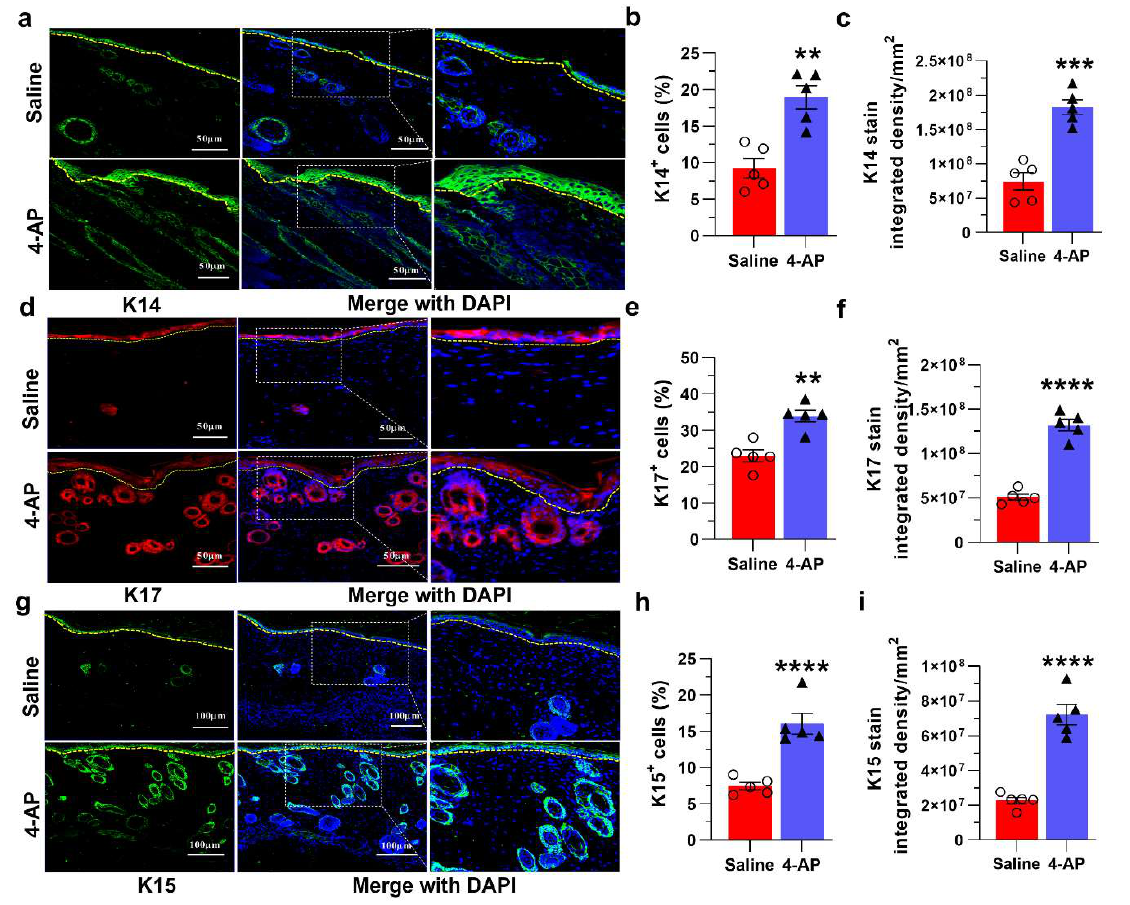
Figure 2. 4-AP increases keratinocyte number and epithelial stem-cell markers in healing wounds. ( a ) Representative images of Keratin 14 protein expression by immunofluorescence in healed epi- dermis. K14 (green); DAPI (blue) denotes nucleus and dashed line denotes epidermal/dermal border. ( b , c ) Percent of K14 + cells and K14 protein integrated density in saline-control and 4-AP-treated skin wounds at day 14. Scale bars = 50 μm. Data represents 20 images from 5 different mouse wounds and are shown as mean ± SEM, n = 5 animals per group, statistical significance indicated by asterisks (O = saline mouse data points, ∆ = 4-AP treated mouse data points, ** = p between 0.01 and 0.001, and *** = p between 0.001 and 0.0002 vs. saline). ( d ) Representative images of keratin 17 protein expression by immunofluorescence in saline and 4-AP-treated skin wounds. K17 (red); DAPI (blue) denotes nucleus and dashed line denotes epidermal/dermal border. ( e , f ) Percent of K17 + cells and K17 protein integrated density in control and 4-AP treated skin wounds at day 14; scale bars = 50 μm. Data represents 20 images from 5 different mouse wounds and are shown as mean ± SEM, n = 5 animals per group, statistical significance indicated by asterisks (O = saline mouse data points, ∆ = 4-AP treated mouse data points, ** = p between 0.01 and 0.001, and **** = p between 0.0002 and 0.0001 vs. saline). ( g ) Representative images of keratin 17 protein expression by immunofluorescence in saline and 4-AP-treated skin wounds. K15 (green); DAPI (blue) denotes nu- cleus and dashed line denotes epidermal/dermal border. ( h , i ) Percent of K15 + cells and K15 protein integrated density in saline control and 4-AP-treated skin wounds at day 14. Scale bars =100 μm. Data represents 20 images from 5 different mouse wounds and are shown as mean ± SEM, n = 5 animals per group, statistical significance indicated by asterisks (O = saline mouse data points, ∆ = 4-AP treated mouse data points, **** = p between 0.0002 and 0.0001 vs. saline).